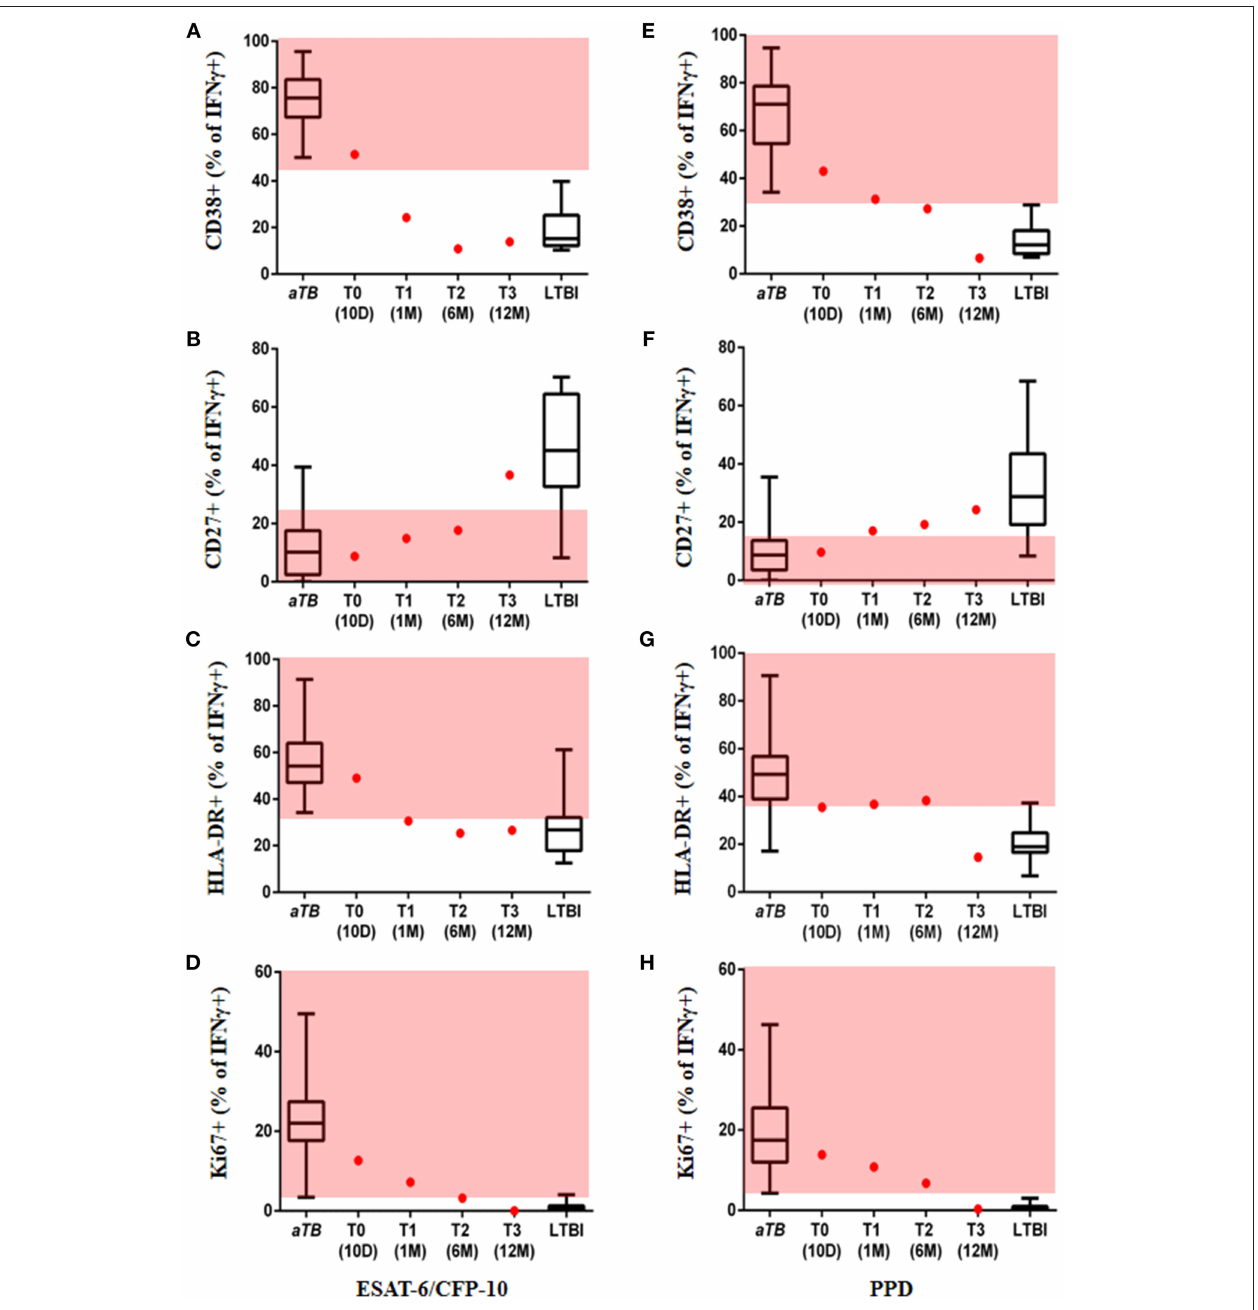
FIGURE 2 | Marker expression on MTB-specific CD4T cells. Values are provided at the start, during and at the end of treatment. Frequency of ESAT-6/CFP-10 stimulated MTB-specific CD4T cells expressing the markers CD38 (A) , CD27 (B) , HLA-DR (C) , Ki67 (D), and PPD stimulated MTB-specific CD4T cells expressing CD38 (E) , CD27 (F) , HLA-DR (G) , Ki67 (H) are displayed as red dots at 10 days (T0), 1 month (T1), 6 months (T2), and 12 months (T3) after TB treatment initiation; data from subjects with acute pulmonary tuberculosis and healthy/latent TB infection were included as reference (box and whisker plots). Red area represents the region considered to show an active TB profile with cut-offs based on ROC analysis; ROC cut-off values for ESAT-6/CFP-10, CD38 = 44.9, CD27 = 22.1, HLA-DR = 33.15, Ki67 = 2.43 and for PPD, CD38 = 31.55, CD27 = 18.35, HLA-DR = 35.7, Ki67 = 3.67 (14).